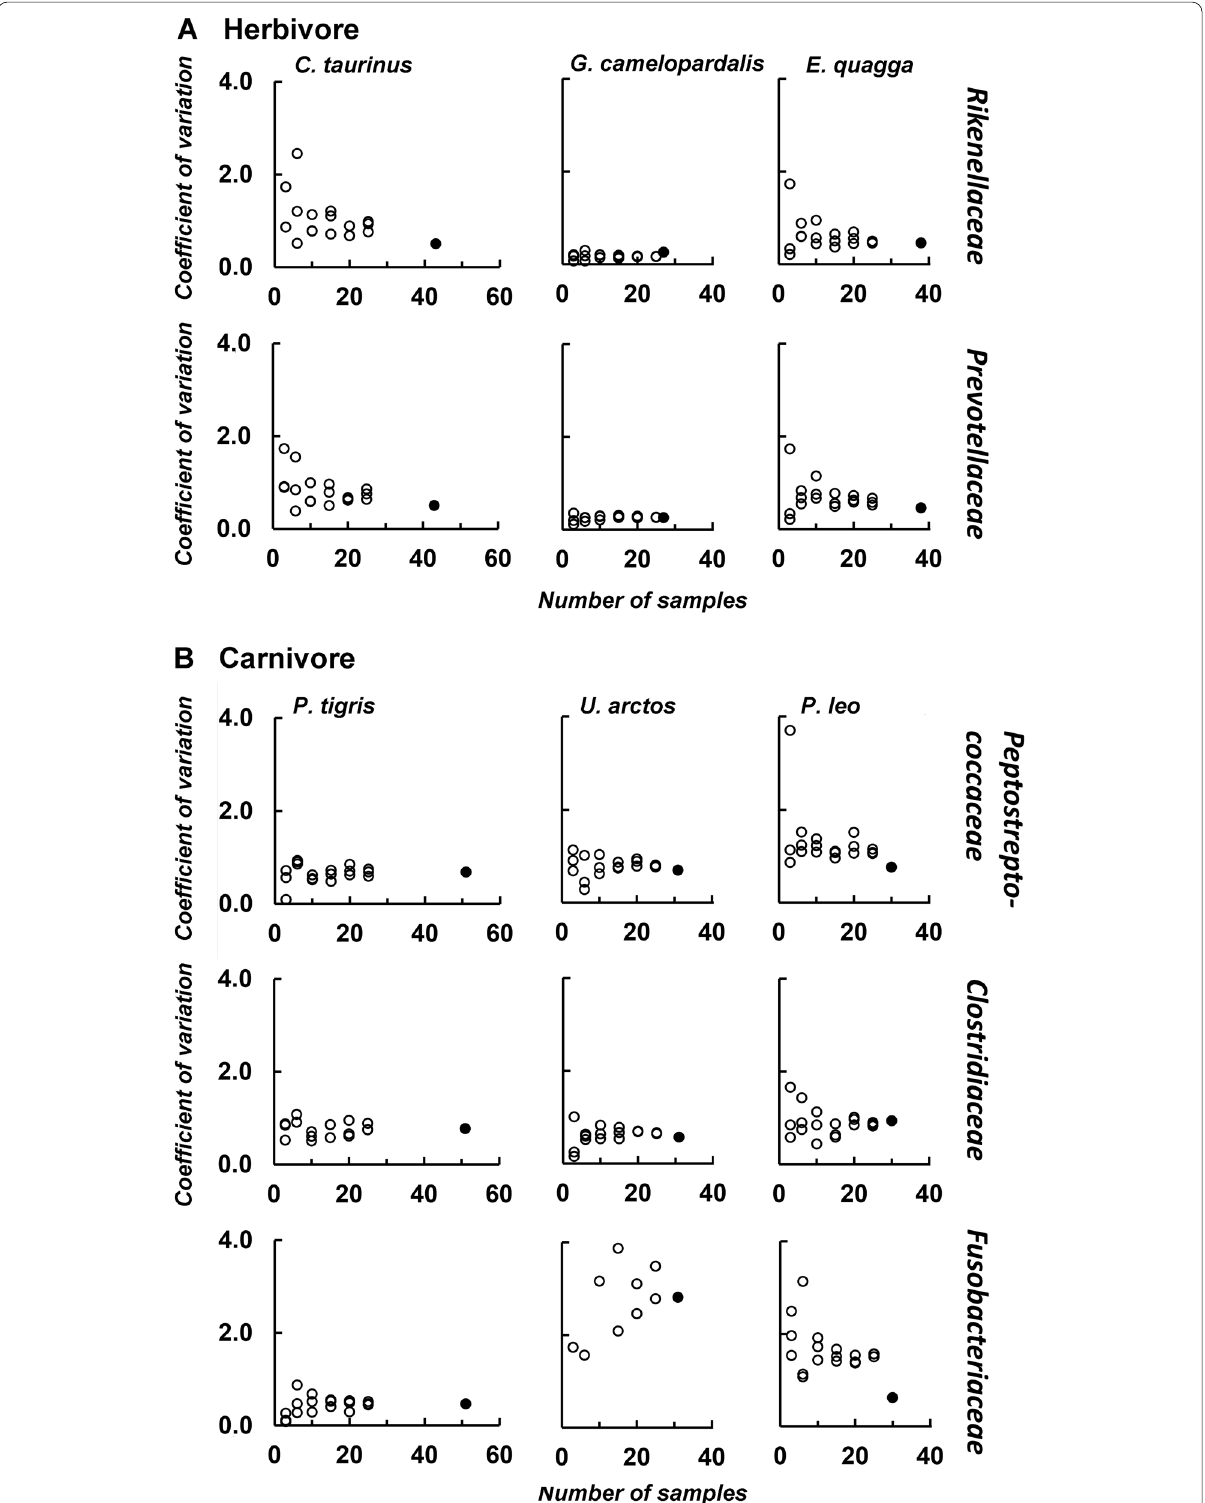
Fig. 5 Coefficient of variation of different bacterial families for selected herbivorous ( A ) and carnivorous ( B ) species. Shown are randomized subsets (unfilled circles) for a different number of samples, as well as the entire data set (filled